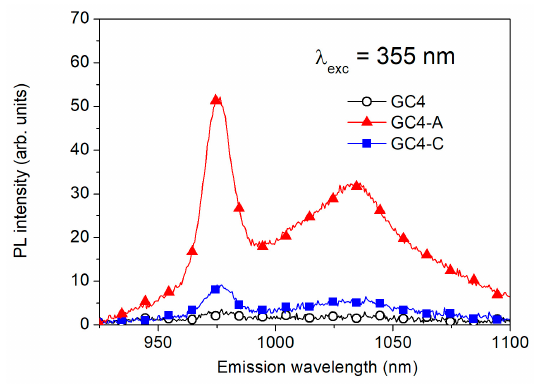
Figure 4. Near-infrared photoluminescence emission of Yb doped samples before Ag-exchange (GC4), after Ag-exchange (GC4-A) and after Ag-exchange and annealing (GC4-C). It can be observed that 355 nm is a very weak excitation wavelength for Yb 3+ ions, while it results in a strong PL emission in Ag-containing samples.